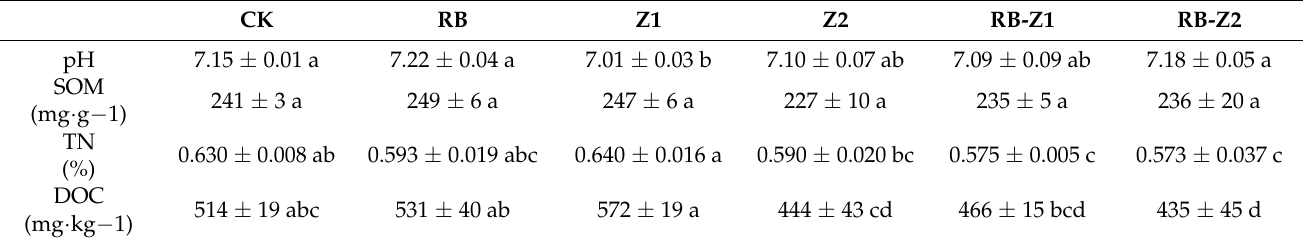
Table 4. Physicochemical properties of soil samples under different